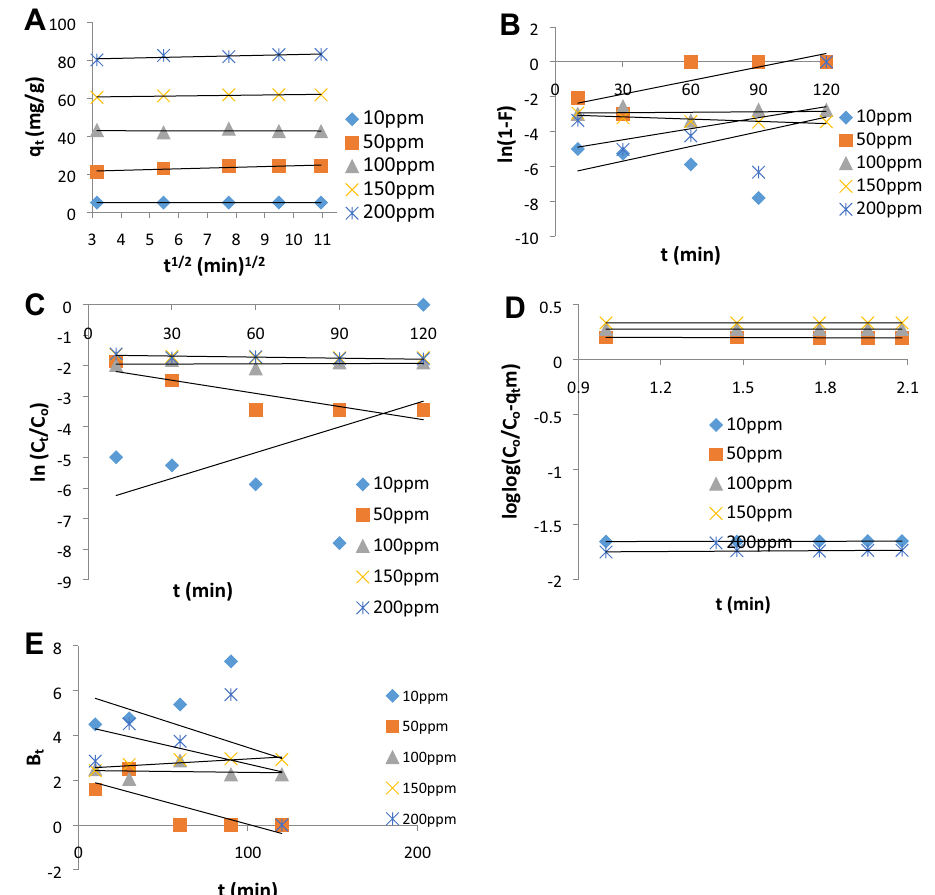
Figure 3. Linearized plots of ( A ) intraparticle diffusion, ( B ) liquid film diffusivity, ( C ) external diffusion, ( D ) Bangham and ( E ) Boyd models for adsorption of Cu 2+ onto nZVI at 10 ppm, 50 ppm, 100 ppm, 150 ppm and 200 ppm.